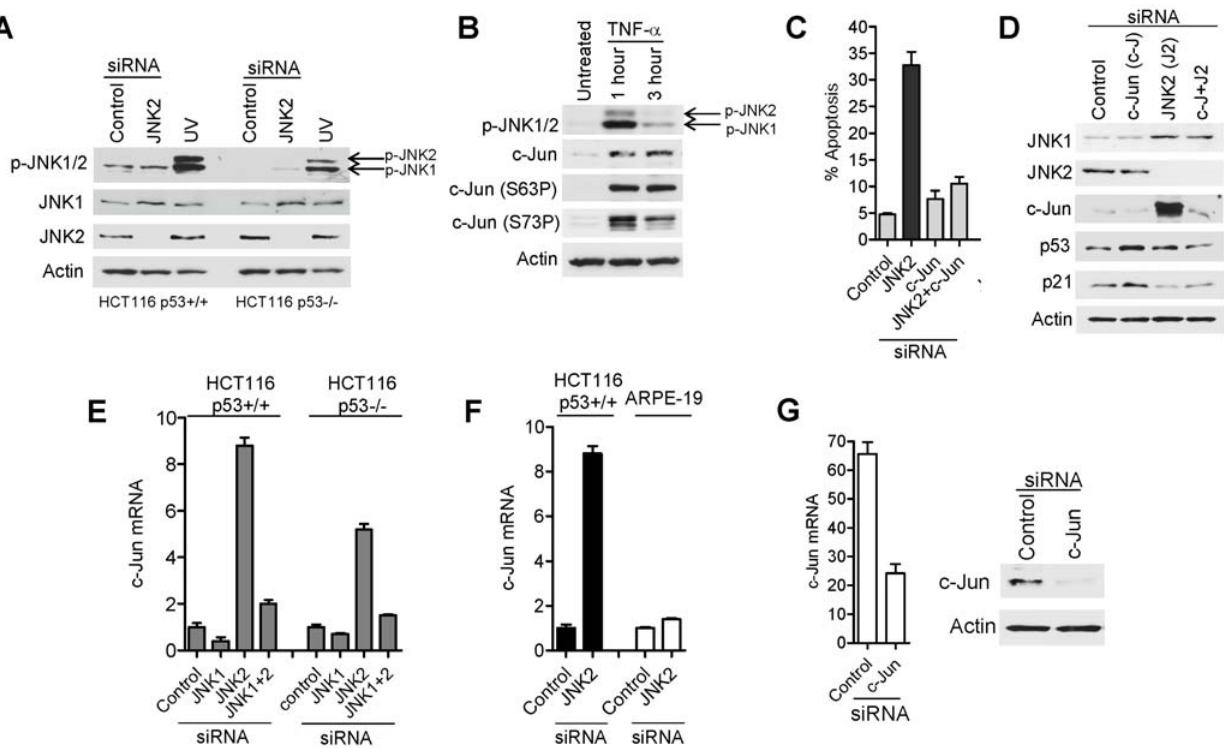
Figure 2. JNK1 and c-Jun, required for basal apoptosis, remain hypo-phosphorylated following JNK2 silencing whereas both are hyper-phosphorylated in response to stress. (A) Comparison of JNK1/JNK2 phosphorylation status in control, JNK2-silenced and following UV- irradiation (HCT116 cells; Methods). p-JNK1 = phosphorylated JNK1, pJNK2 = phosphorylated JNK2 (arrowed). (B) Effects of TNF a on phosphorylation status of JNK1, JNK2 and c-Jun. (C) Co-silencing c-Jun with JNK2 rescues HCT116 cells from apoptosis (annexin V labelling; Methods). (D) JNK1, JNK2 and c-Jun protein levels 48 h post RNAi-mediated silencing of JNK2 and c-Jun. P53 and p21 protein levels are also shown. (E) c-Jun mRNA levels after JNK1 and JNK2 silencing. (F) Fold increase in c-Jun mRNA levels in HCT116 cells compared with ARPE19 cells 48 h after JNK2 silencing. (G) Knockdown of c-Jun mRNA and protein levels in HCT116 p53 + / + cells following c-Jun siRNA treatment.